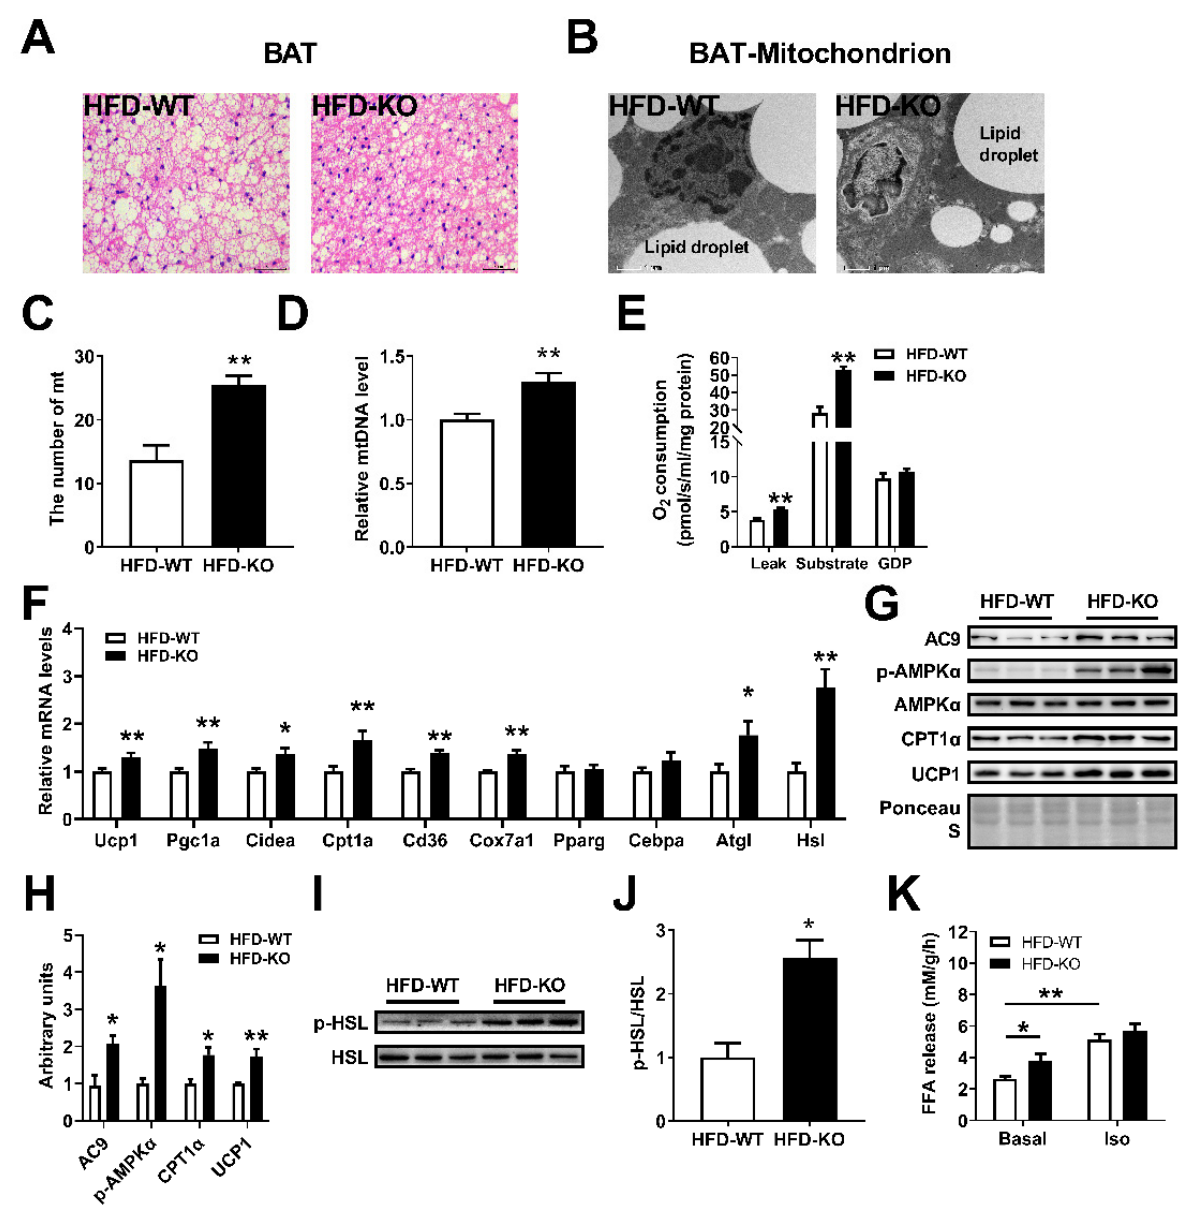
Figure 5. miR-143KO promoted thermogenesis and lipolysis of BAT in HFD fed mice. ( A , B ) Morpho- logic analysis of adipocytes and mitochondria in BAT of WT and KO mice. Scale bars: 100 µ m and 1 µ m. ( C , D ) Mitochondria number and the relative copy number of mitochondrial DNA in BAT of WT and KO mice (n = 8). ( E ) The oxygen consumption of mitochondria isolated from BAT of WT and KO mice fed HFD for 1 week (n = 4). ( F – J ) The thermogenic and lipolysis-related genes mRNA (n = 8) and protein expression levels in the BAT of WT and KO mice fed HFD. ( K ) Fatty acid release capacity of BAT from WT and KO mice fed HFD for 1 week (n = 4). Data are presented as the mean ± SEM. * p < 0.05 vs. controls; ** p < 0.01 vs. controls, as determined by a two-tailed unpaired Student’s t